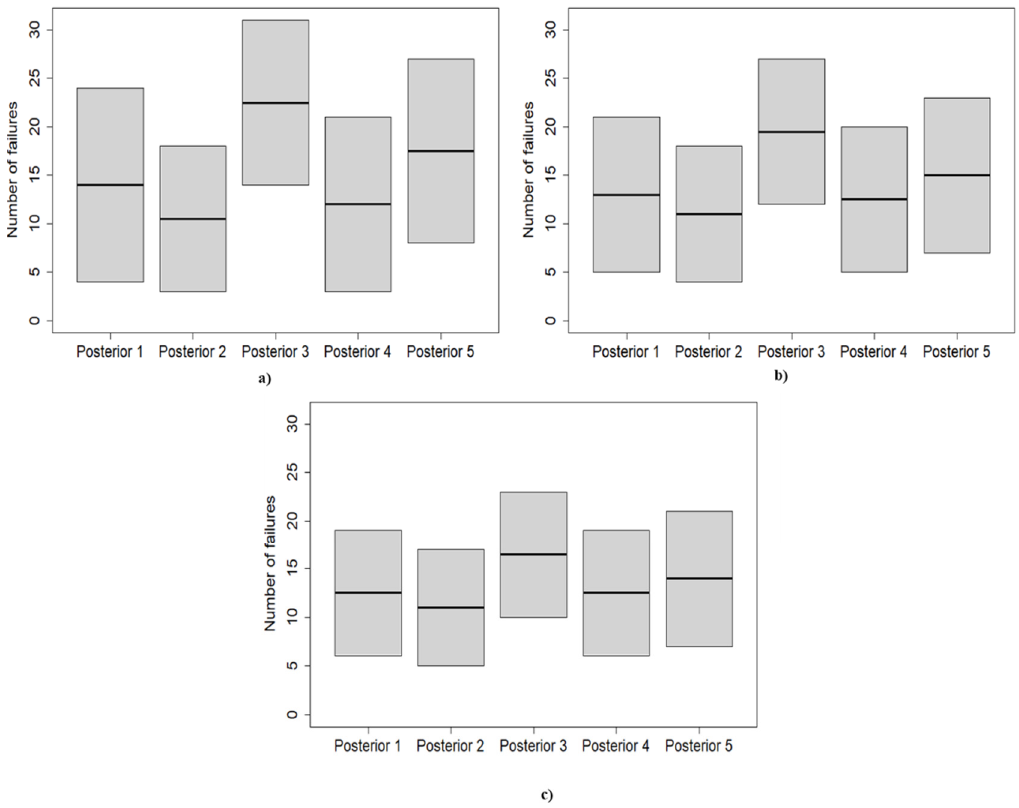
Figure 7. Boxplot of the expected number of failures corresponding to a 0.90 confidence interval. ( a – c ) refers to the PPDs calculated for the first, second, and third applications, respectively.